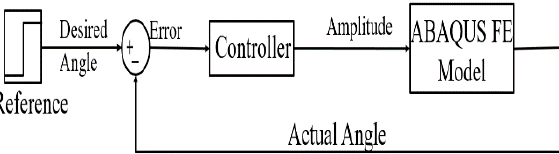
Figure 19. Closed loop block diagram.